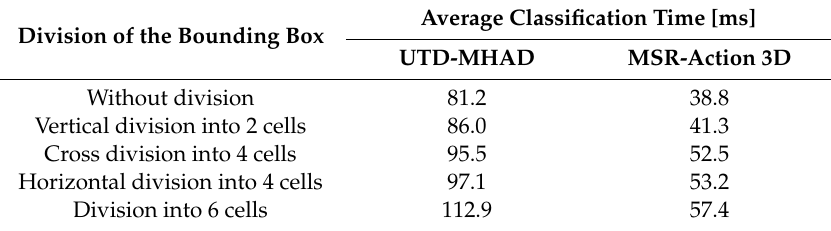
Table 7. Classification